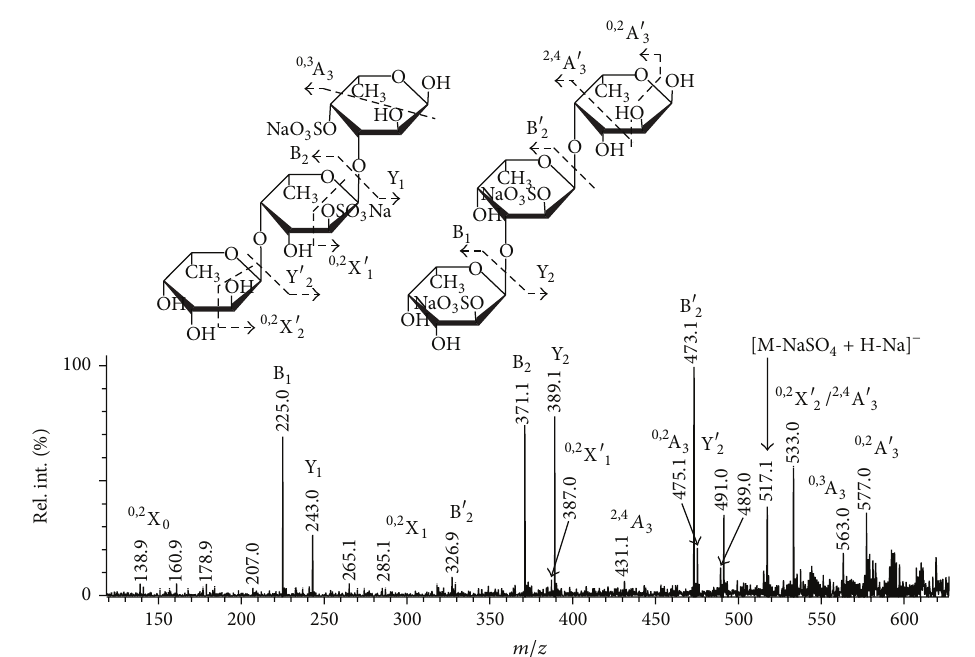
Figure 3: Negative-ion tandem MALDI-TOFMS ion at m/z 637.07. M represents sodium salt of oligosaccharide.